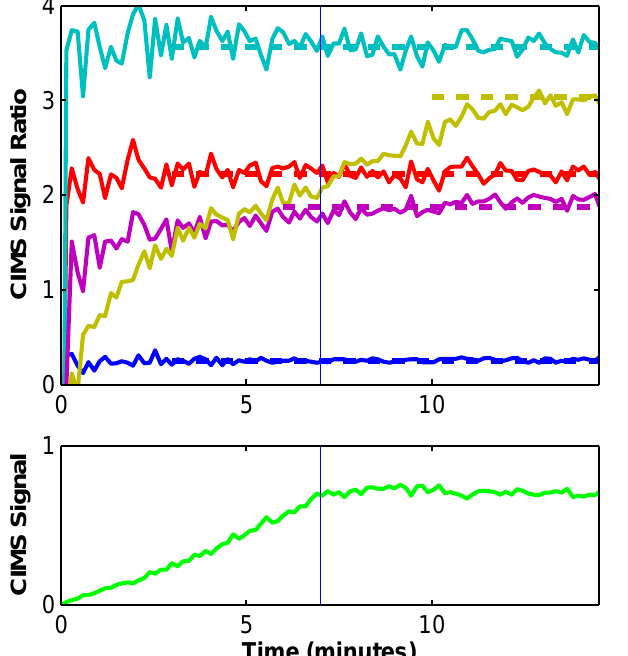
Figure 2. β -hydroxy nitrate products produced from six alkenes during Exp. 19. The top panel shows the ratio of CIMS hydroxy nitrate (HN) signals to propene HN (206 m/z ) for ethene HN (192 m/z , blue), methylpropene HN (220 m/z , red), 2-methyl,2-butene HN (234 m/z , teal), 1-hexene HN (248 m/z , purple), and 1-octene HN (276 m/z , gold). The bottom panel shows the absolute signal for propene HN (206 m/z ). The lights were turned on at time = 0, and turned off at 7min (vertical line), at which point the oxidation stopped. For all compounds other than hydroxy nitrates from 1-octene, a ratio is plotted as a dashed line using averaged data from 3min after lights until the measurements stopped. For hydroxy nitrates from 1-octene, data after 10min are averaged. The time lag for hydroxy nitrates from 1-octene arises from wall and sample line equilibration. This suggests that the measured yield is a lower limit.